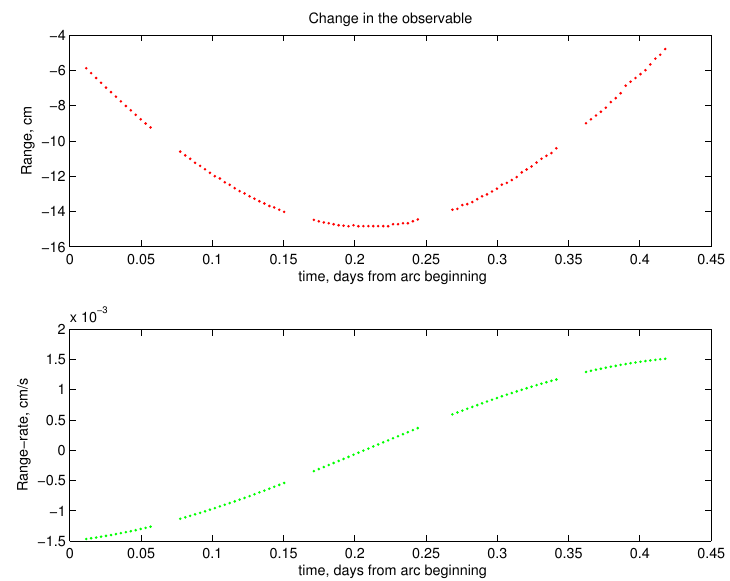
Figure 5. The difference in the observables range and range-rate for one pass of Mercury above the horizon for a ground station, by using an hybrid model in which the position and velocity of the orbiter have not been transformed to TDB-compatible quantities and a correct model in which all quantities are TDB-compatible. Gaps of the signal are due to spacecraft passage behind Mercury as seen for the Earth station. ( Top ): for a hybrid model with the satellite position and velocity not transformed to TDB-compatible; ( Bottom ): for a hybrid model with the position and velocity of the antenna not transformed to